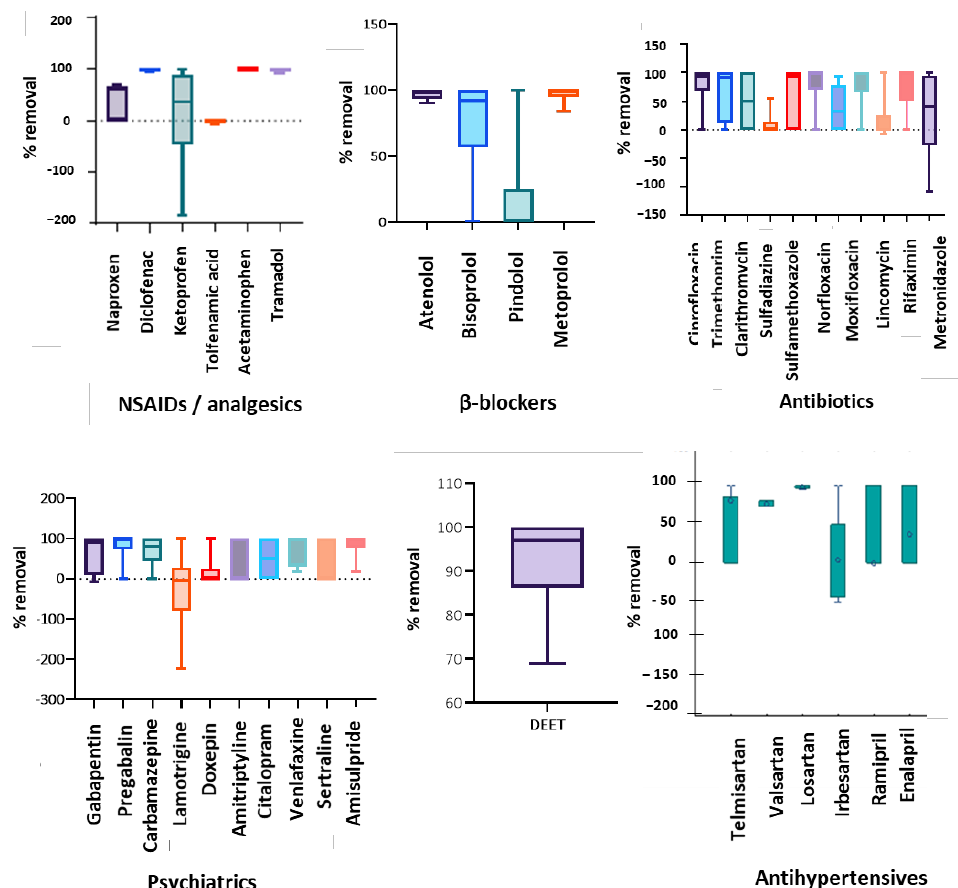
Figure 2. Removal efficiency for the main therapeutic classes investigated in this study .